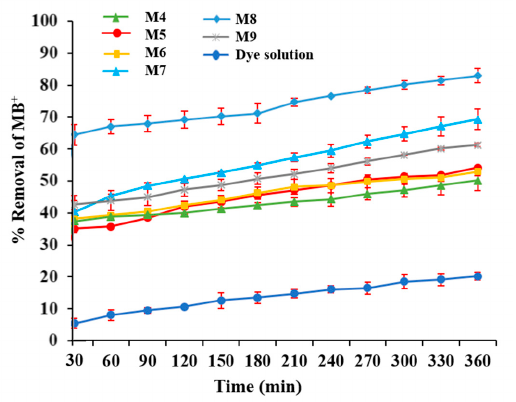
Figure 10. Comparison of dye removal using a catalyst-free (M4–M6) and GO-filled (M7–M9) membranes and dye solution degradation without a membrane under visible light irradiation.